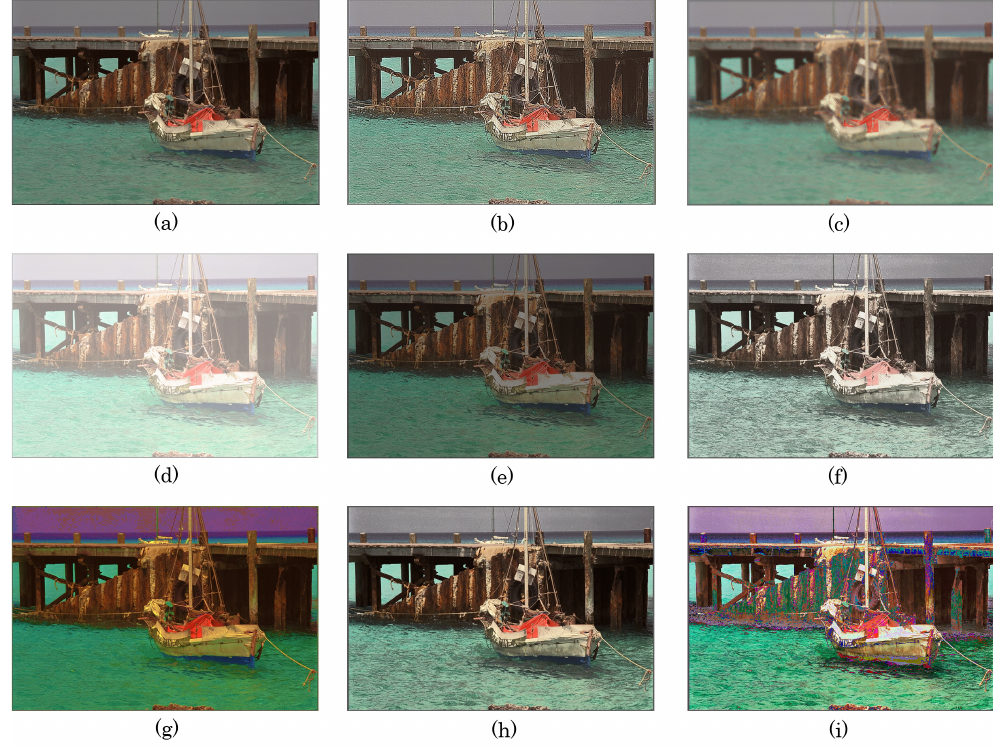
Figure 7. Maximum level of each brightness control and saturation improvement (kodim11). ( a ) Raw image. ( b ) Sharpening ( I VSH = 3). ( c ) Smoothing ( I VSM = 4). ( d ) Brightness increase ( I VI = 140). ( e ) Brightness decrease ( I VD = 139). ( f ) CE ( I VC = 59). ( g ) Saturation improvement ( I S = 182). ( h ) CE under previous method [12] ( I VC = 50). ( i ) CE under previous method [1] ( I VC =